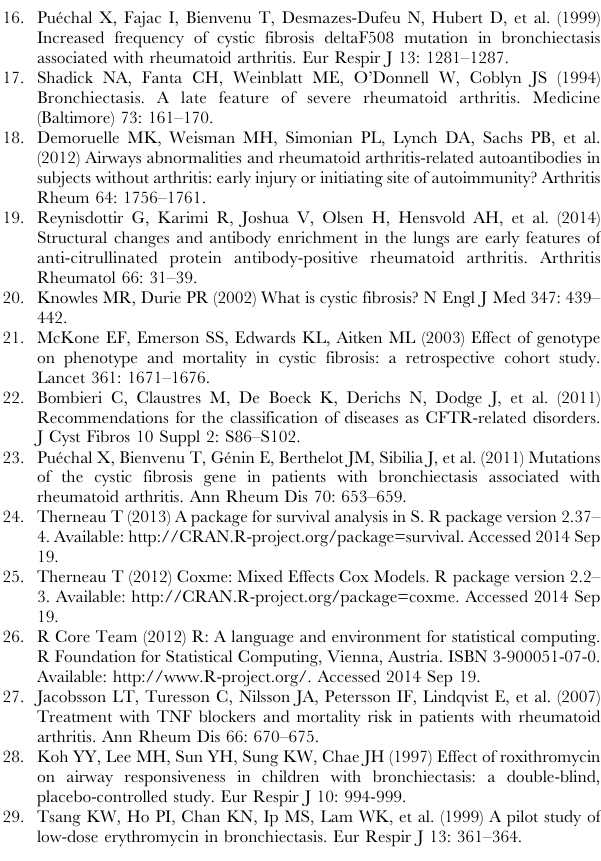
Figure S1 Kaplan-Meier probability of survival from birth of the various participants in the study cohort as a function of their phenotype. Panel A. Kaplan-Meier survival curves from birth for the various groups of individuals. Panel B. groups, compared with unaffected relatives as the reference